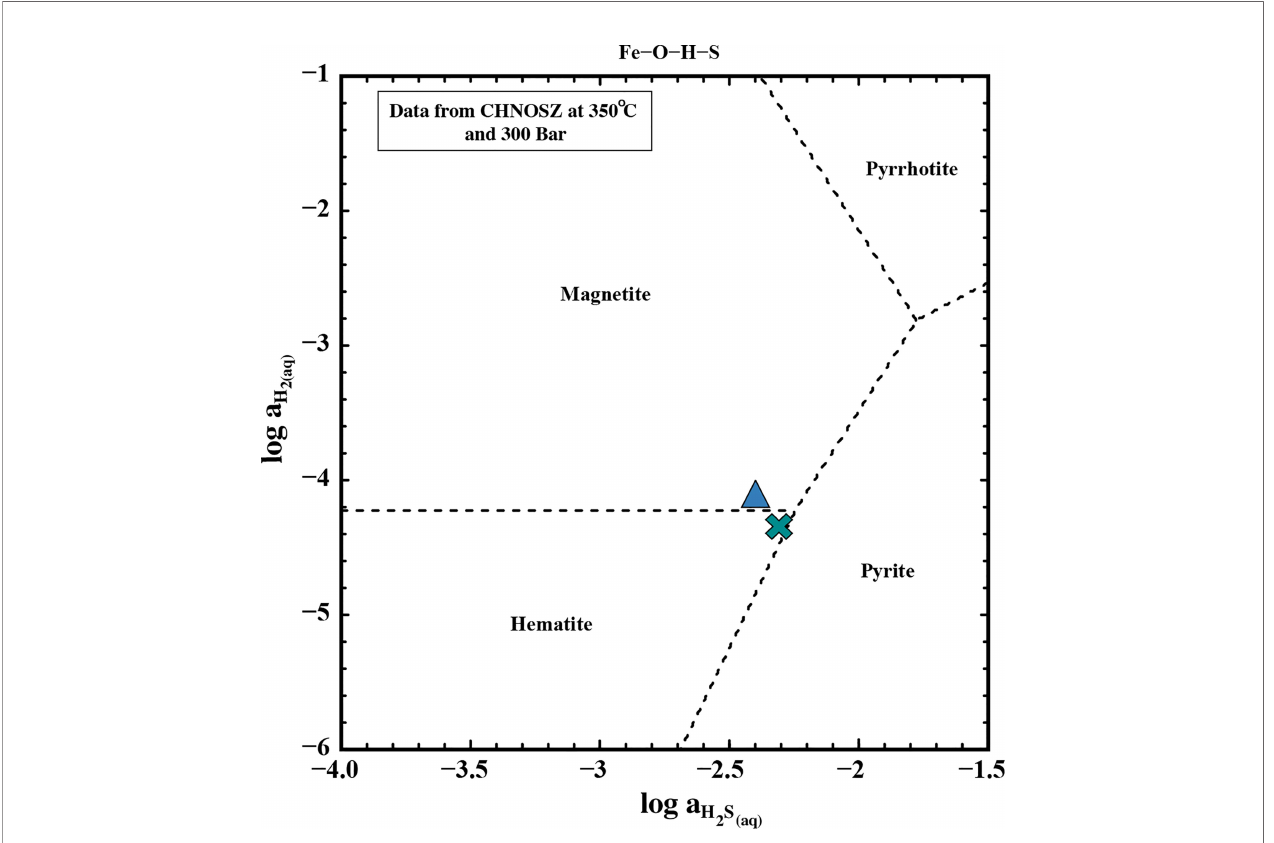
FIGURE 8 | Activity diagram showing the phase relations in a Fe-O-H-S system at 350°C and 300 bar. The data to plot the mineral fi elds were acquired using CHNOSZ (Dick, 2019). The blue triangle represents endmember data from the fl uid at Iced Bun and the green cross represents endmember data from Dog ’ s